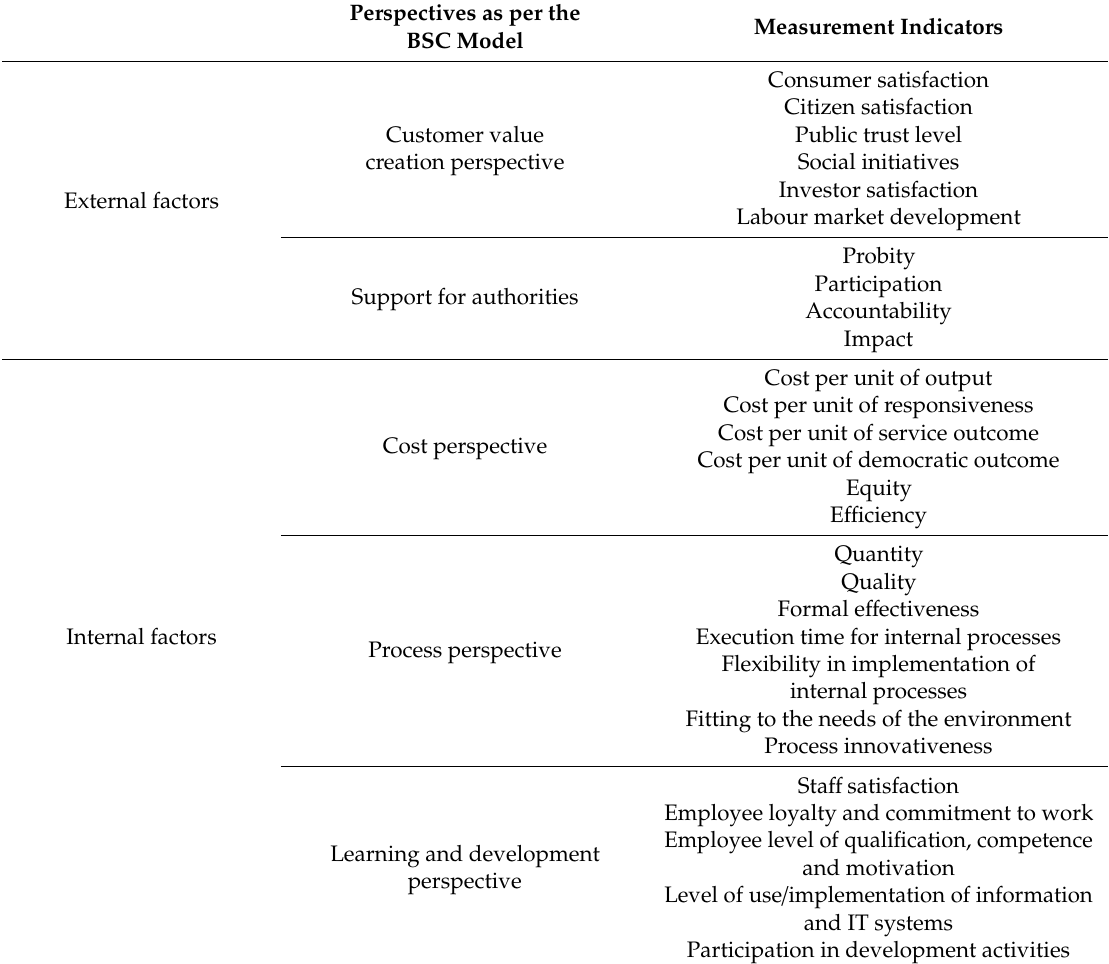
Table 4. Performance measurement indicators recommended for local government authorities, grouped according to the Balance Scorecard (BSC) model